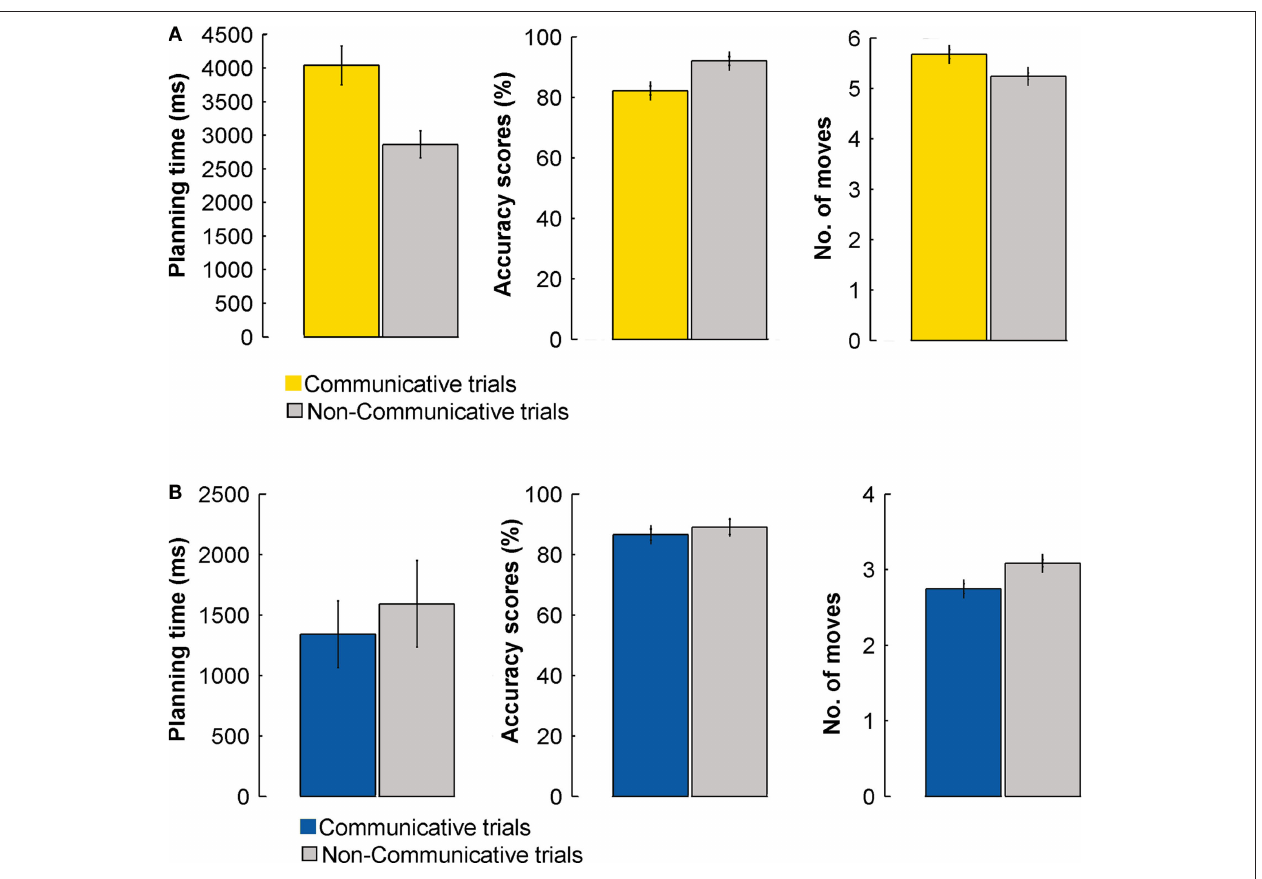
FIGURE 7 | Performance during COMMUNICATIVE and NON - COMMUNICATIVE trials – behavioral data for the fMRI experiment. (A) Planning times (ms), accuracy scores (%), and number of moves of the sender for COMMUNICATIVE and